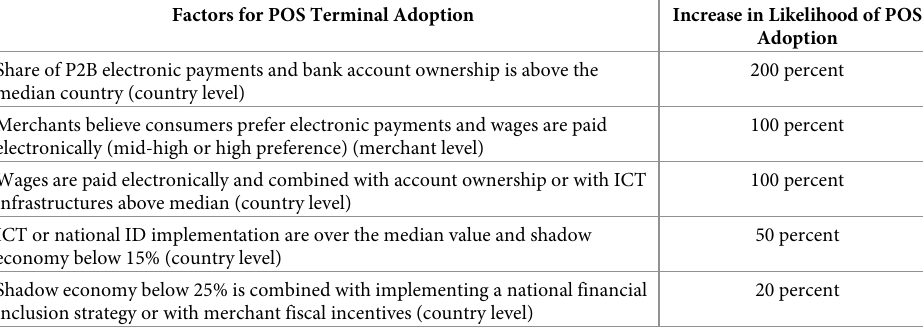
Table 2. Factors influencing POS terminal adoption. Factors for POS Terminal